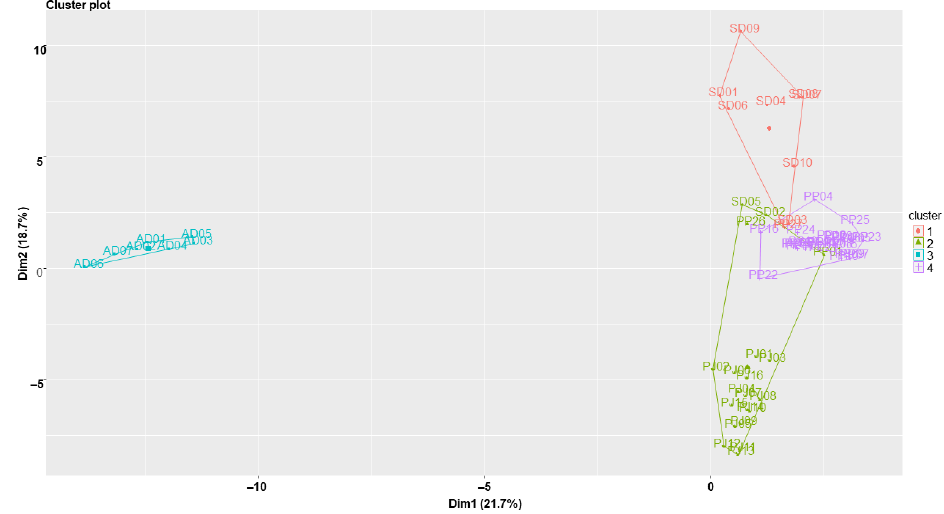
Figure 4. k-Means clustering plot of Peucedanum japonica , P. praeruptorum , Angelica decursiva , and Saposhnikovia divaricata samples. Dim: dimension. PJ: Peucedanum japonicum , PP: P. praeruptorum , AD: Angelica decursiva , SD: Saposhnikovia divaricata